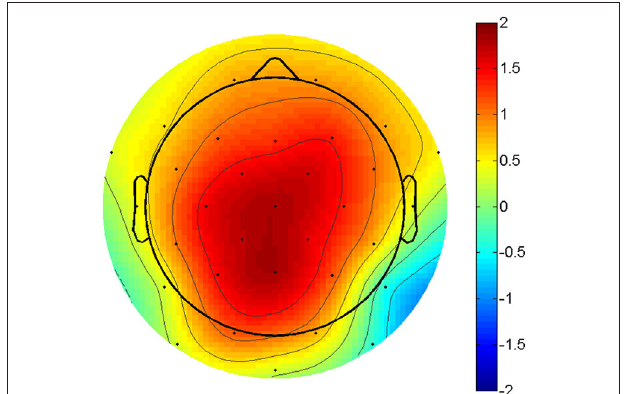
FIGURE 1 | P3 amplitude difference. Topographic plot of the amplitude difference between compatible and incompatible outcomes at 300ms post stimulus. Scaling from -2 to 2 µ V. Voltage maximum is at centro-parietal midline